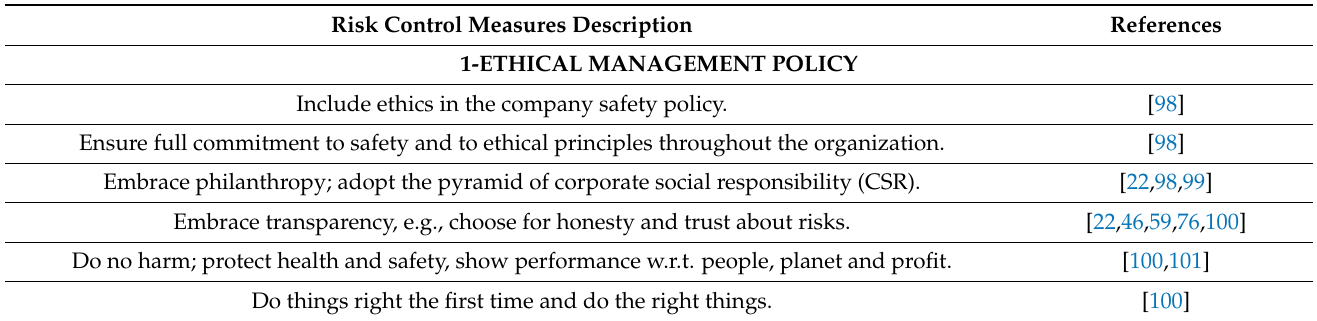
Table 2. Misconduct and transgression risk control measures, best